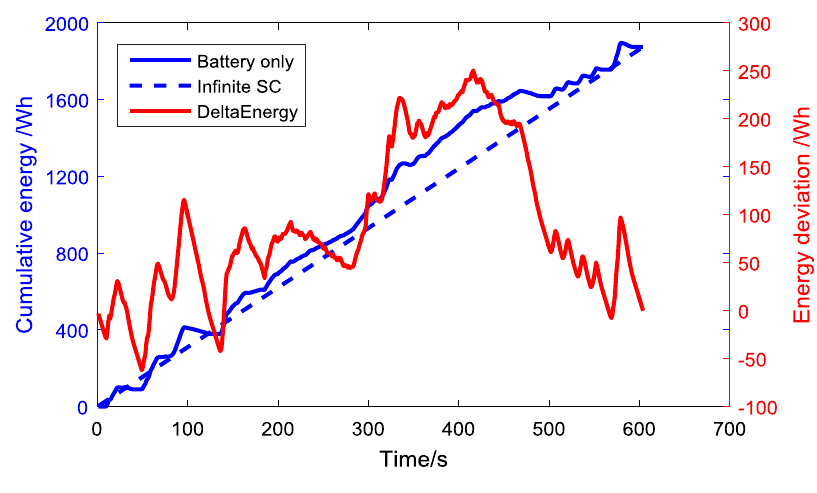
Figure 3. Energy deviation on US06.